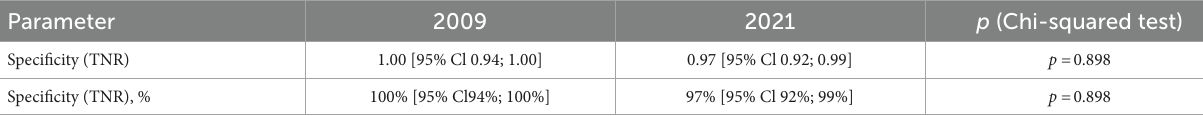
TABLE 7 Comparative results of RTA test specificity in 2009 and 2021.